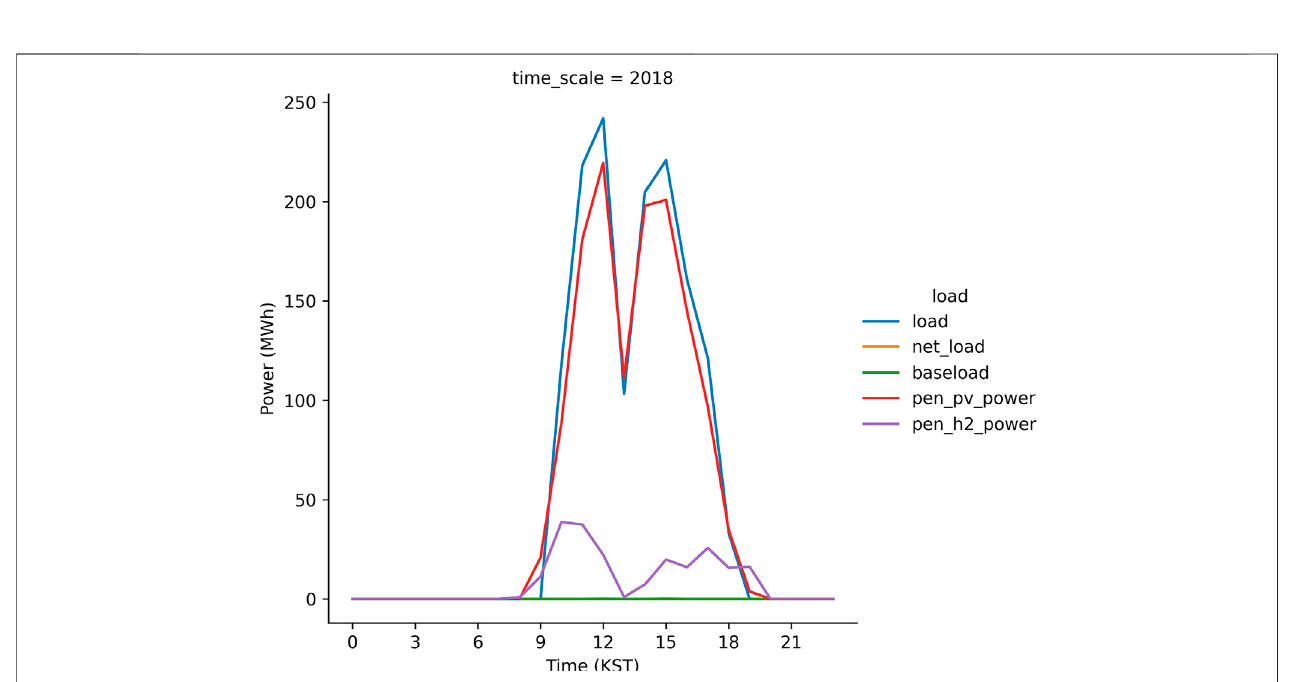
FIGURE8| Atimeseriesofpeakload (blueline) ,solarpowergenerationconnectedintogrid (redline) andelectricitygenerationduetoPEMsystem (purpleline) from the S1 run in 2018. Y -axis in the fi gure is offset by the baseload (green line) to highlight the peak load during daytime.